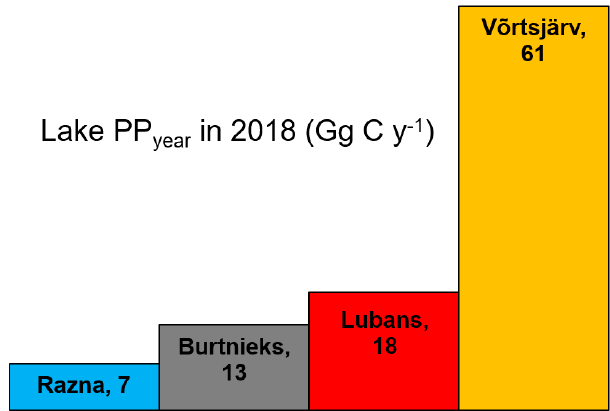
− 1 ) in four studied lakes during